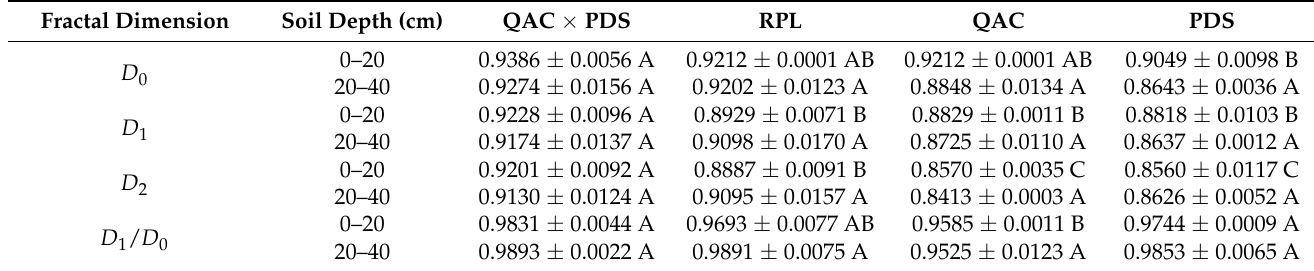
Table 2. Multifractal dimension of soil particle of four vegetation restoration